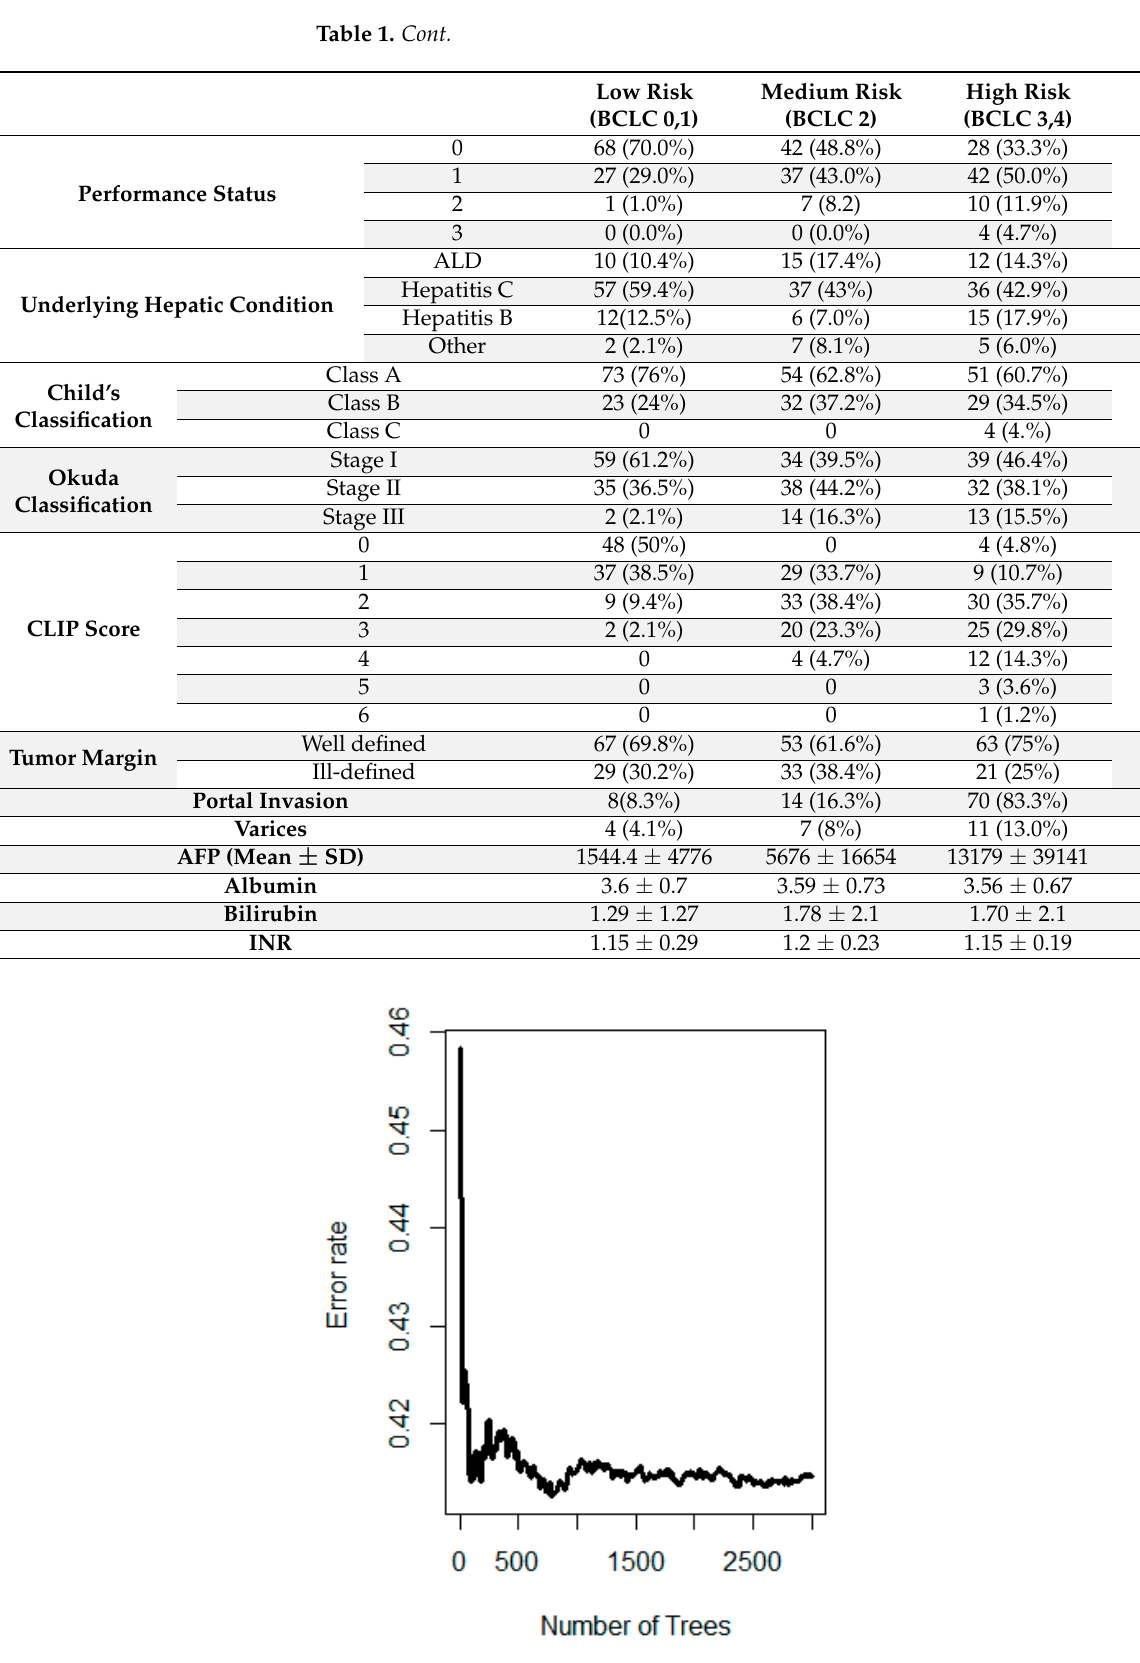
Figure 2. Error rate plotted against number of trees used in the random forest protocol.